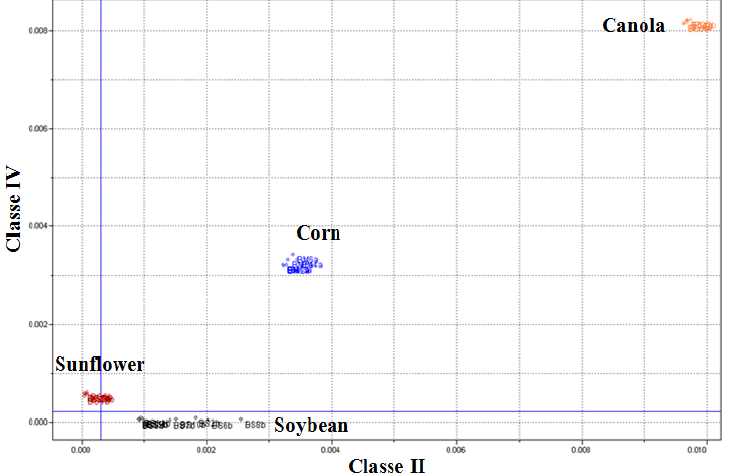
Figure 8. SIMCA Model—Distance between the classes for the training biodiesel samples (Class II versus Class IV).